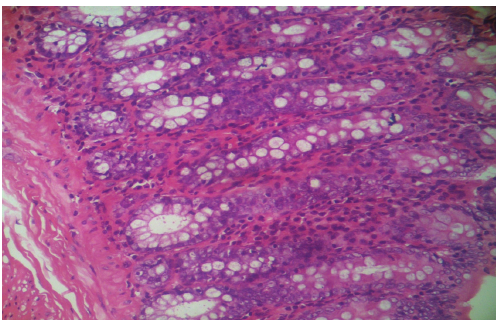
Figure 2: Normal colonic mucosa (H&E, × 200).